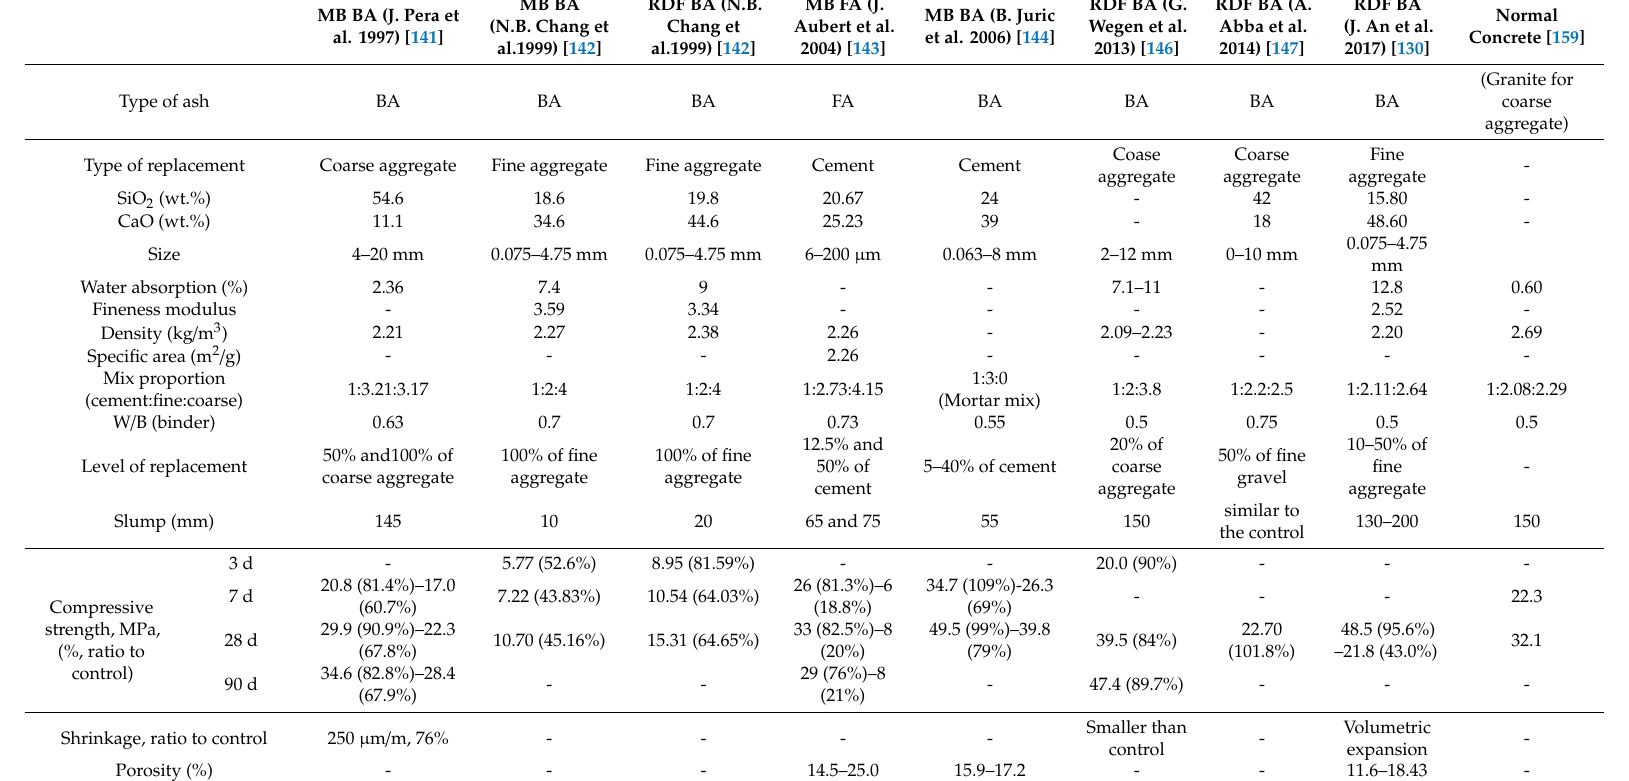
Table 5. Chemical compositions and physical and mechanical properties of ash-blended